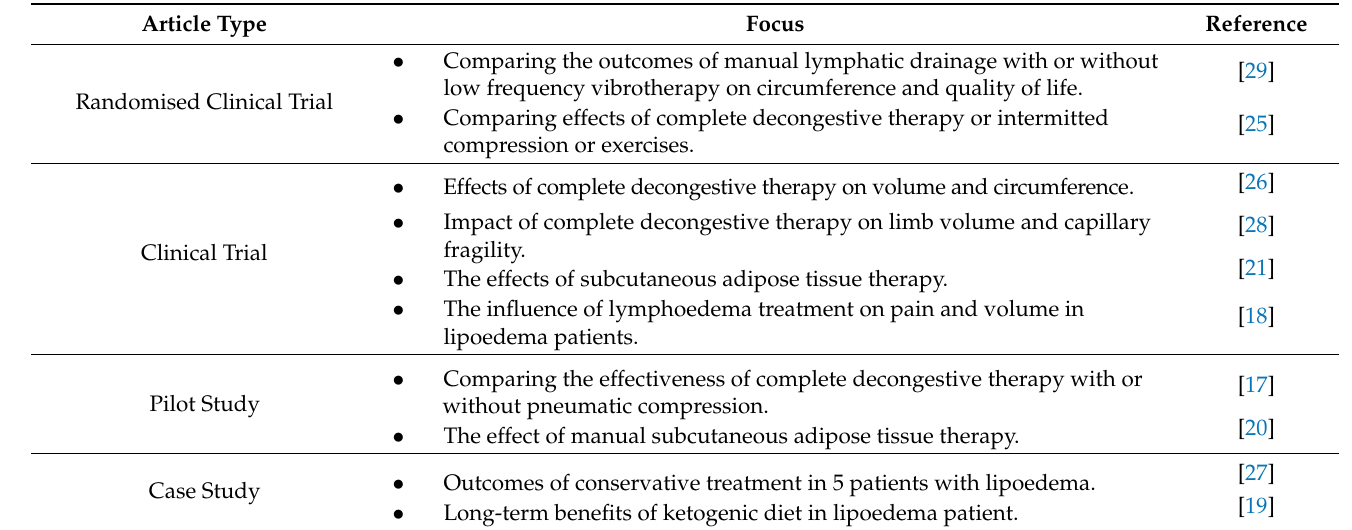
Table 1. Description of articles included according to